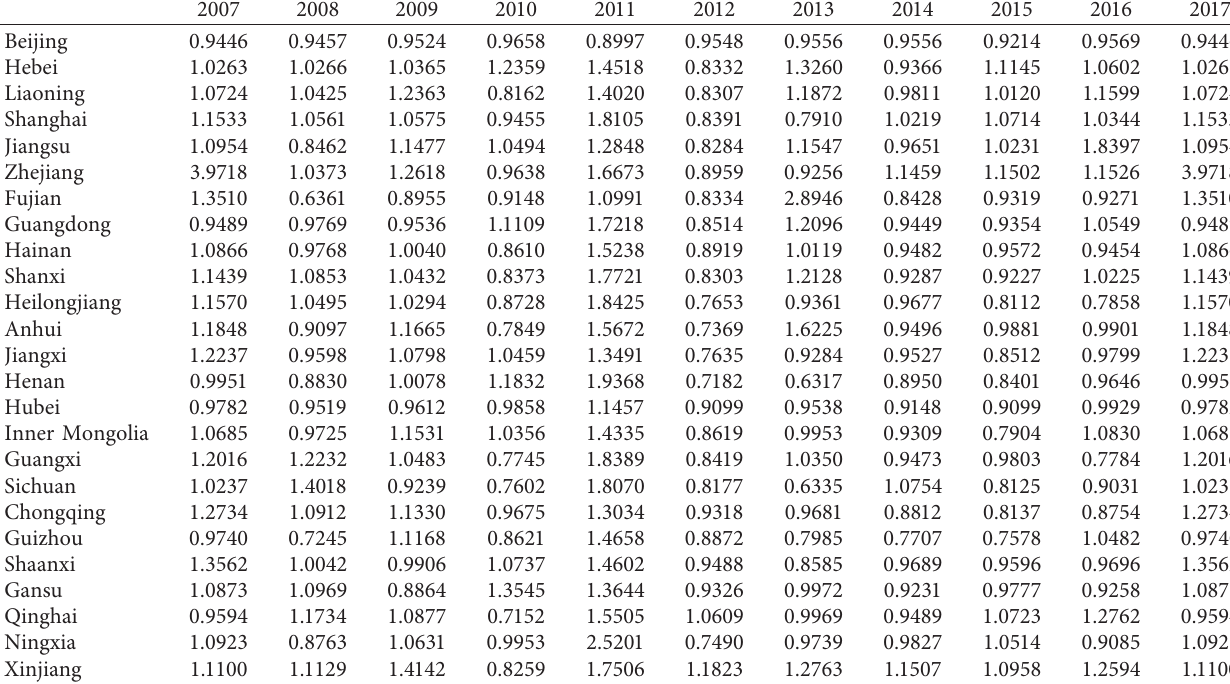
Table 4: Calculation results of the leapfrogging index of carbon emission reduction technology of 25 provinces.